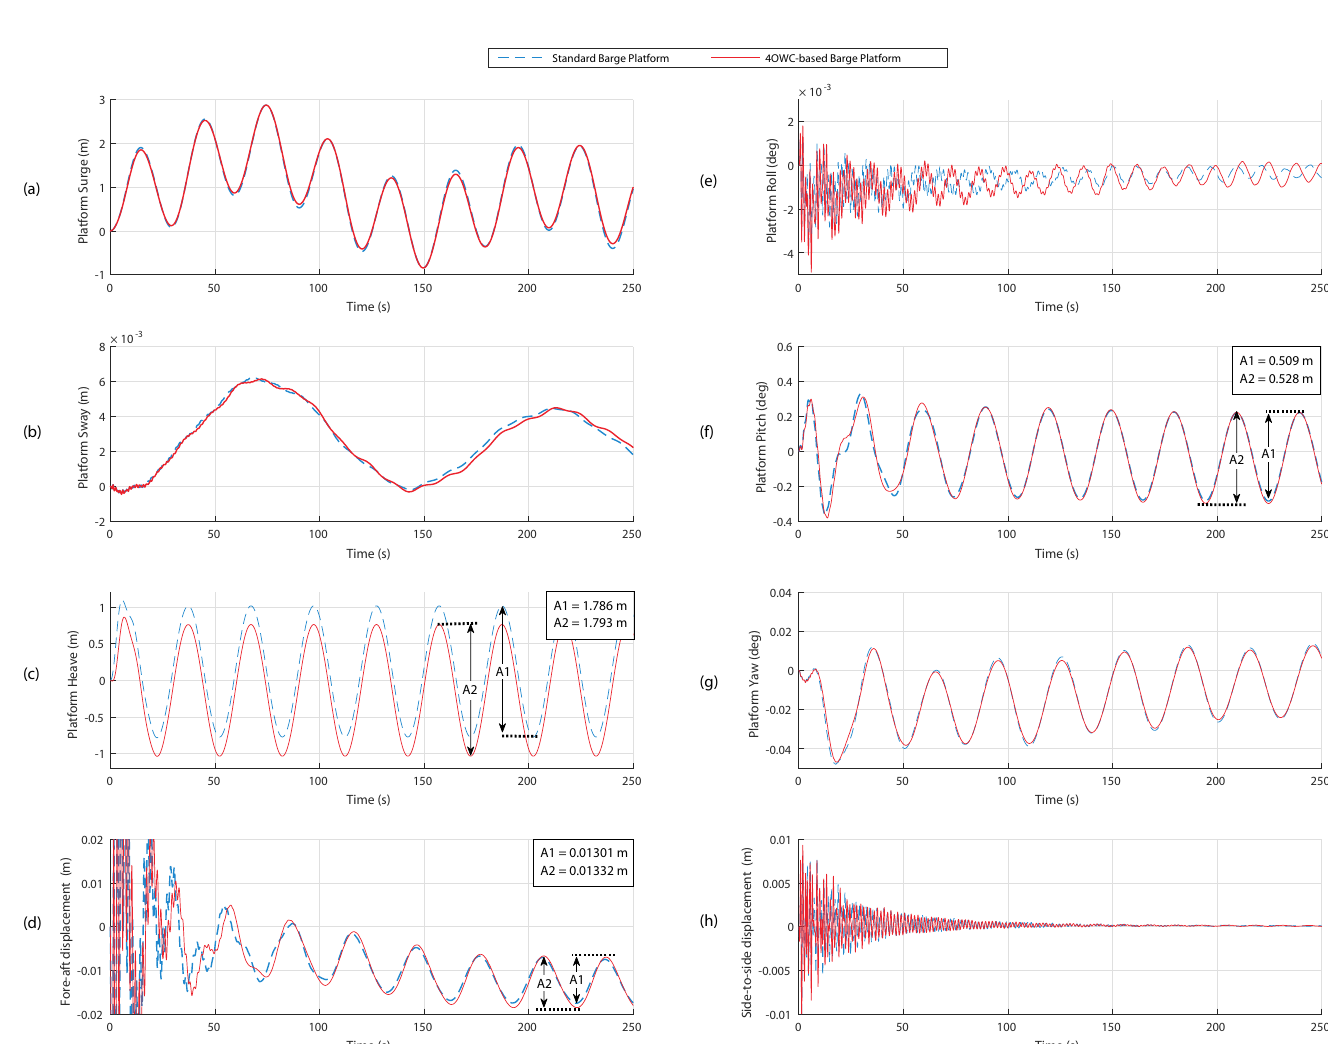
Figure 14. Platforms’ modes for ( a ) Surge. ( b ) Sway. ( c ) Heave. ( d ) Fore-aft. ( e ) Roll. ( f ) Pitch. ( g ) Yaw. ( h )